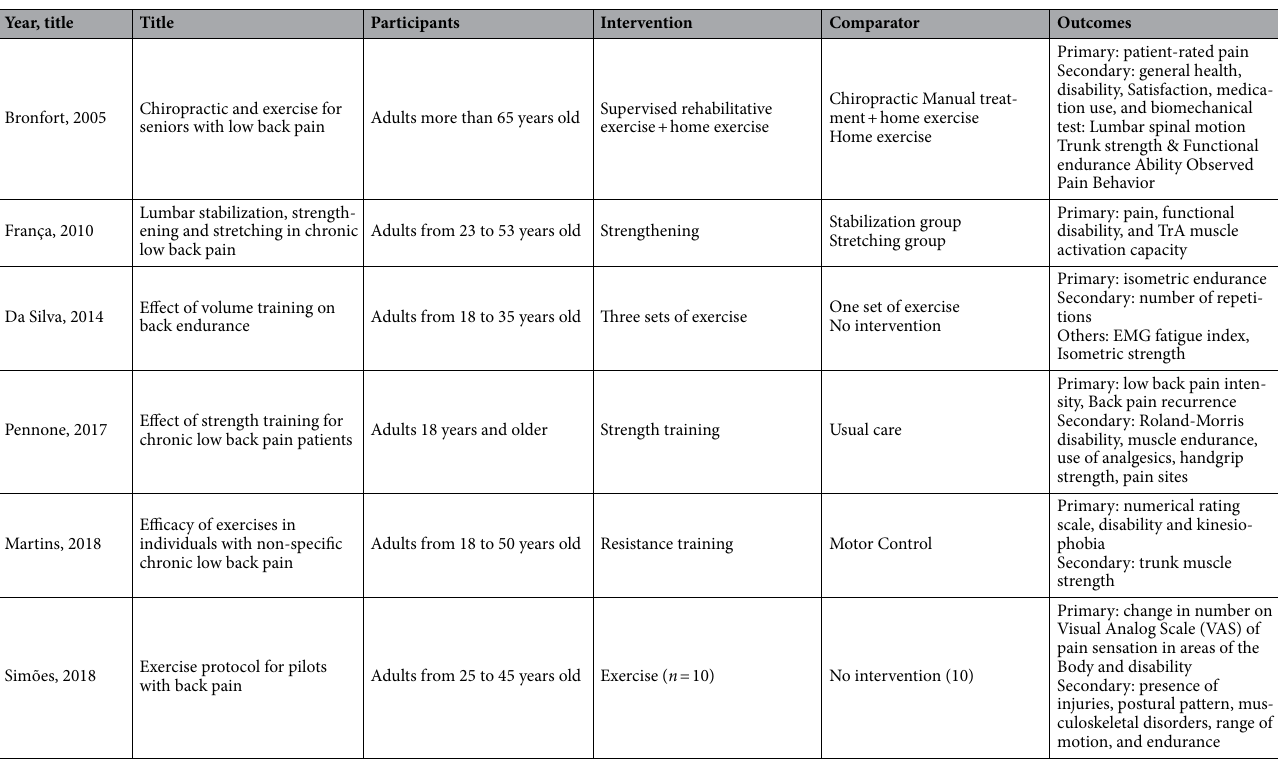
Table 2. Ongoing studies identified on web-based protocol